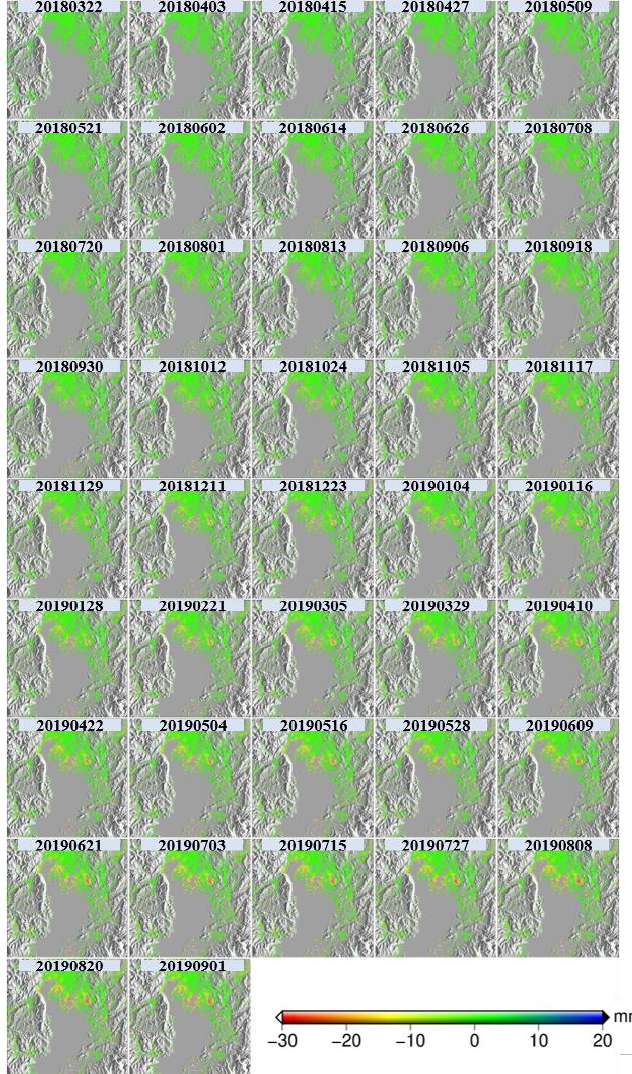
Figure A6. Time series deformation in Kunming observed using C-band Sentinel-1A images with descending orbit between 22 March 2018 and 1 September 2019.